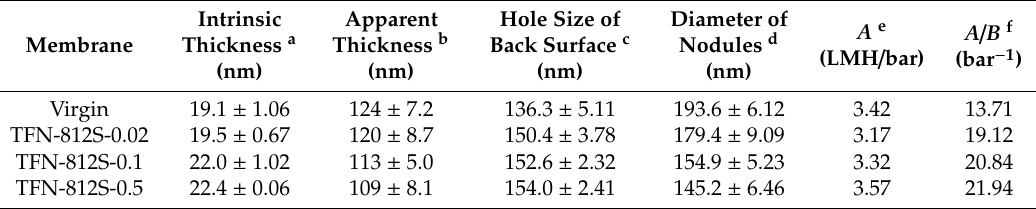
Figure 7. AFM images of the top surfaces of membranes with different concentrations of R812S NPs: ( a ) no NPs, ( b ) 0.02% ( w / v ), ( c ) 0.1% ( w / v ) and ( d ) 0.5% ( w / v ). Table 2. Data comparison of the TFC and TFN RO membranes.